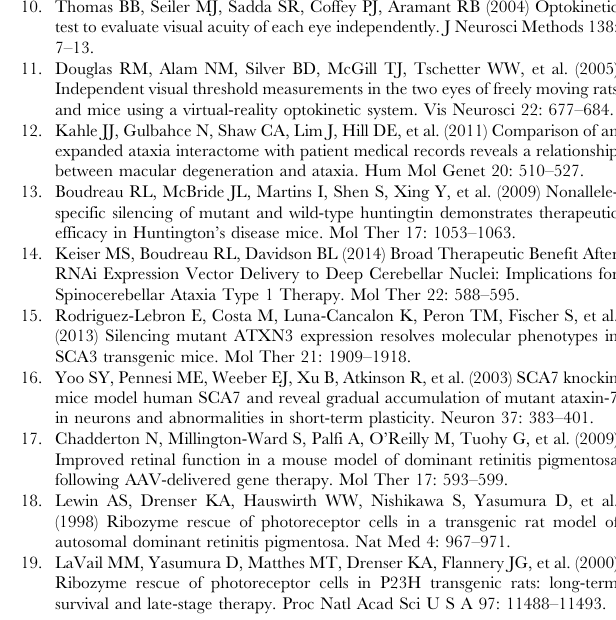
Figure S2 Expression of ataxin-7 mRNA in mouse and human retinas. In situ mRNA analysis for detection of ataxin-7 mRNA expression in mouse (n= 3) and human retina (n=